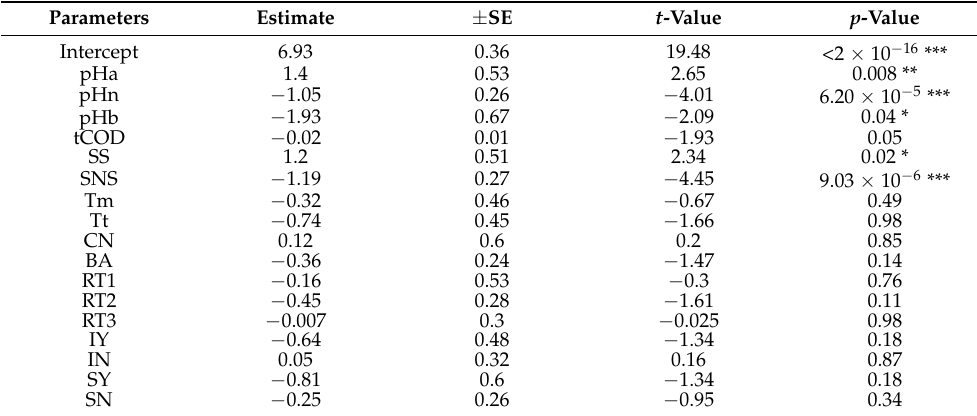
Table 5. Correlation between hydrogen yields and operation parameters. Symbols annota-